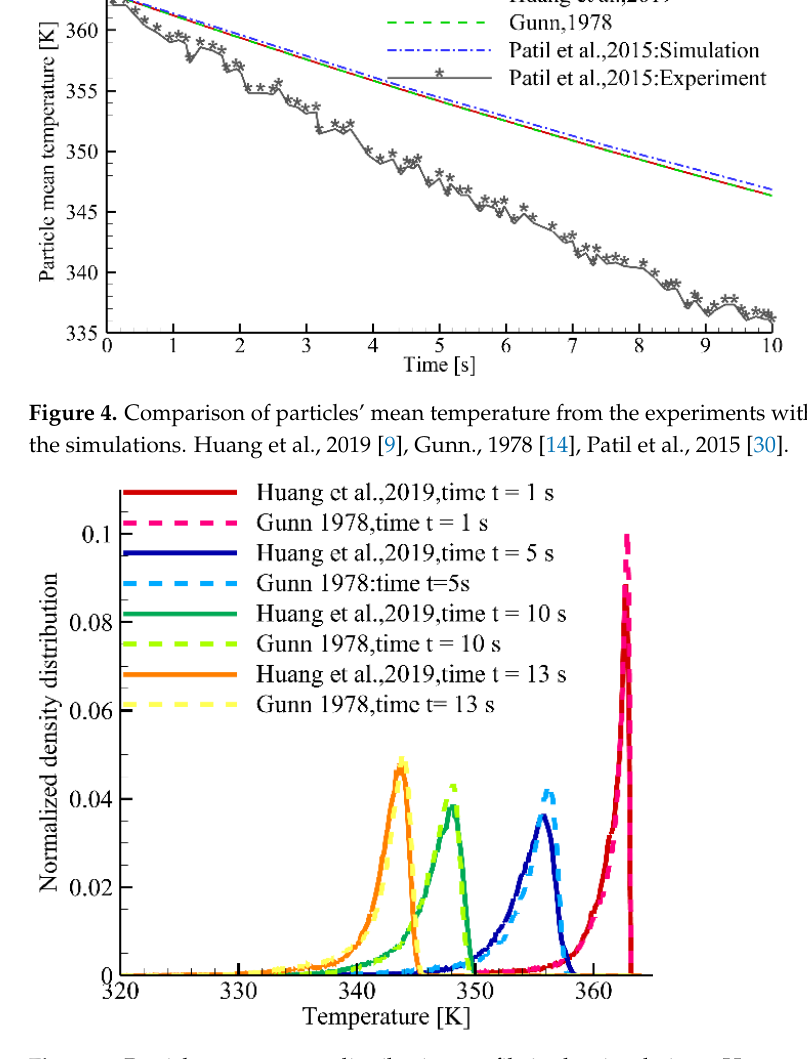
Figure 5. Particle temperature distribution profile in the simulations. Huang et al., 2019 [9], Gunn., 1978